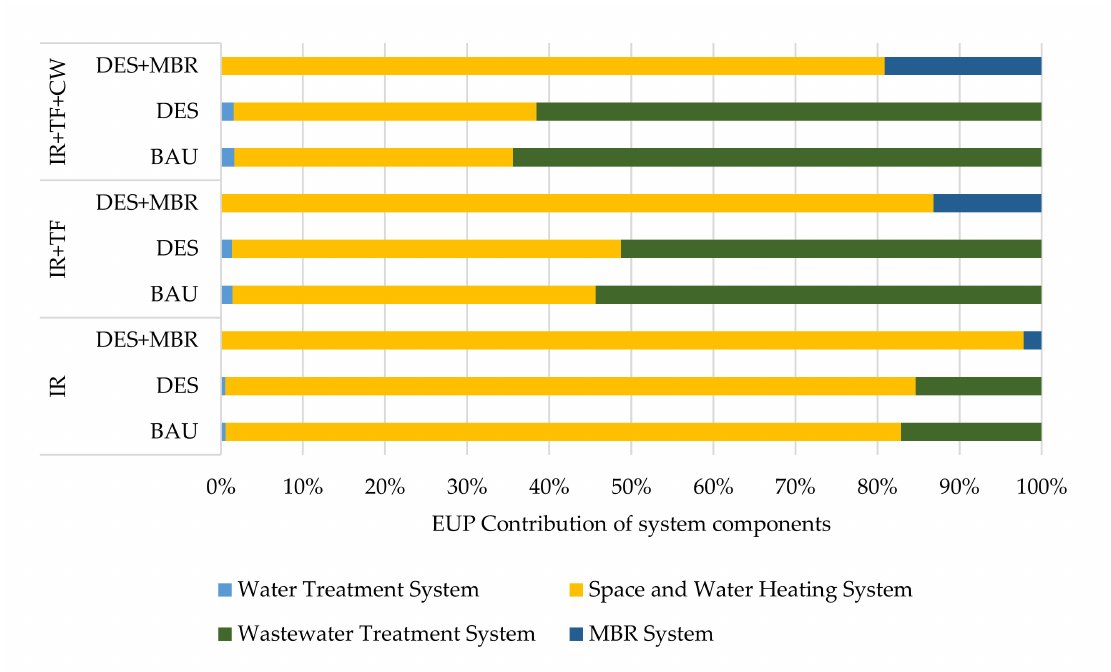
Figure 4. EUP impact contribution of system components for the three study scenarios and water reuse options: business as usual (BAU), district energy system (DES), and district energy system with membrane bioreactor (DES + MBR); irrigation (IR), toilet flushing (TF), and clothes washing (CW).